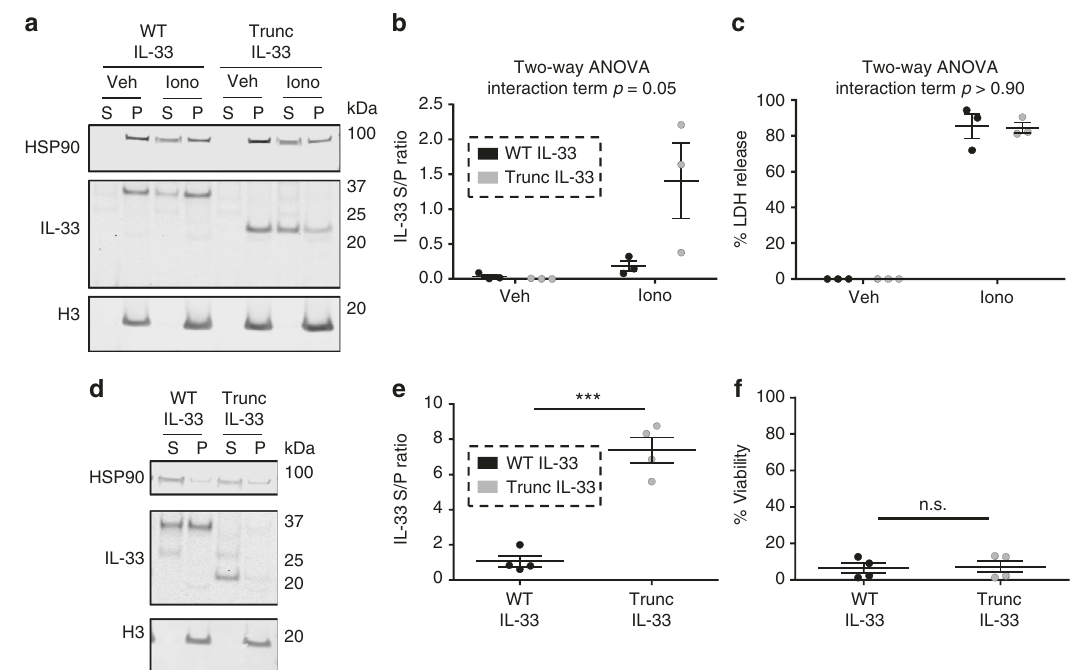
Fig. 5 Chromatin binding reduces IL-33 release during necrosis. a – c TE-7 pools with stable, Dox-inducible overexpression of wild-type (WT) or truncated (Trunc) IL-33 were treated for 4 h with 20 μ M of calcium ionophore A23187 (Iono) or vehicle (Veh). a shows a representative western blot. b is quanti fi cation of the ratio of IL-33 detected in the supernatant vs. the pellet (S/P) by western blot. c is quanti fi cation of the percent release of lactate dehydrogenase (LDH) using enzymatic activity assay, de fi ned as LDH activity in supernatant divided by the total amount in the supernatant plus pellet [S/(S + P)]. b , c depict the mean and standard error of the mean of three independent experiments. Two-way ANOVA interaction terms for IL-33 and % LDH release were p = 0.05 and p > 0.90, respectively. d – f The same pools of IL-33 – overexpressing TE-7 cells were subjected to cryoshock. d shows a representative western blot. e , f are quanti fi cation of the ratio of IL-33 detected in supernatant to pellet ( e ) or cell viability as assessed by Trypan blue exclusion ( f ); presented is the mean and standard error of the mean of three independent experiments. ***, p < 0.001 and n.s.: not signi fi cant by Student ’ s t -test. ANOVA: analysis of variance, Dox: doxycycline, H3: histone H3, HSP90: heat shock protein 90, IL: interleukin, P: cell pellets, S: